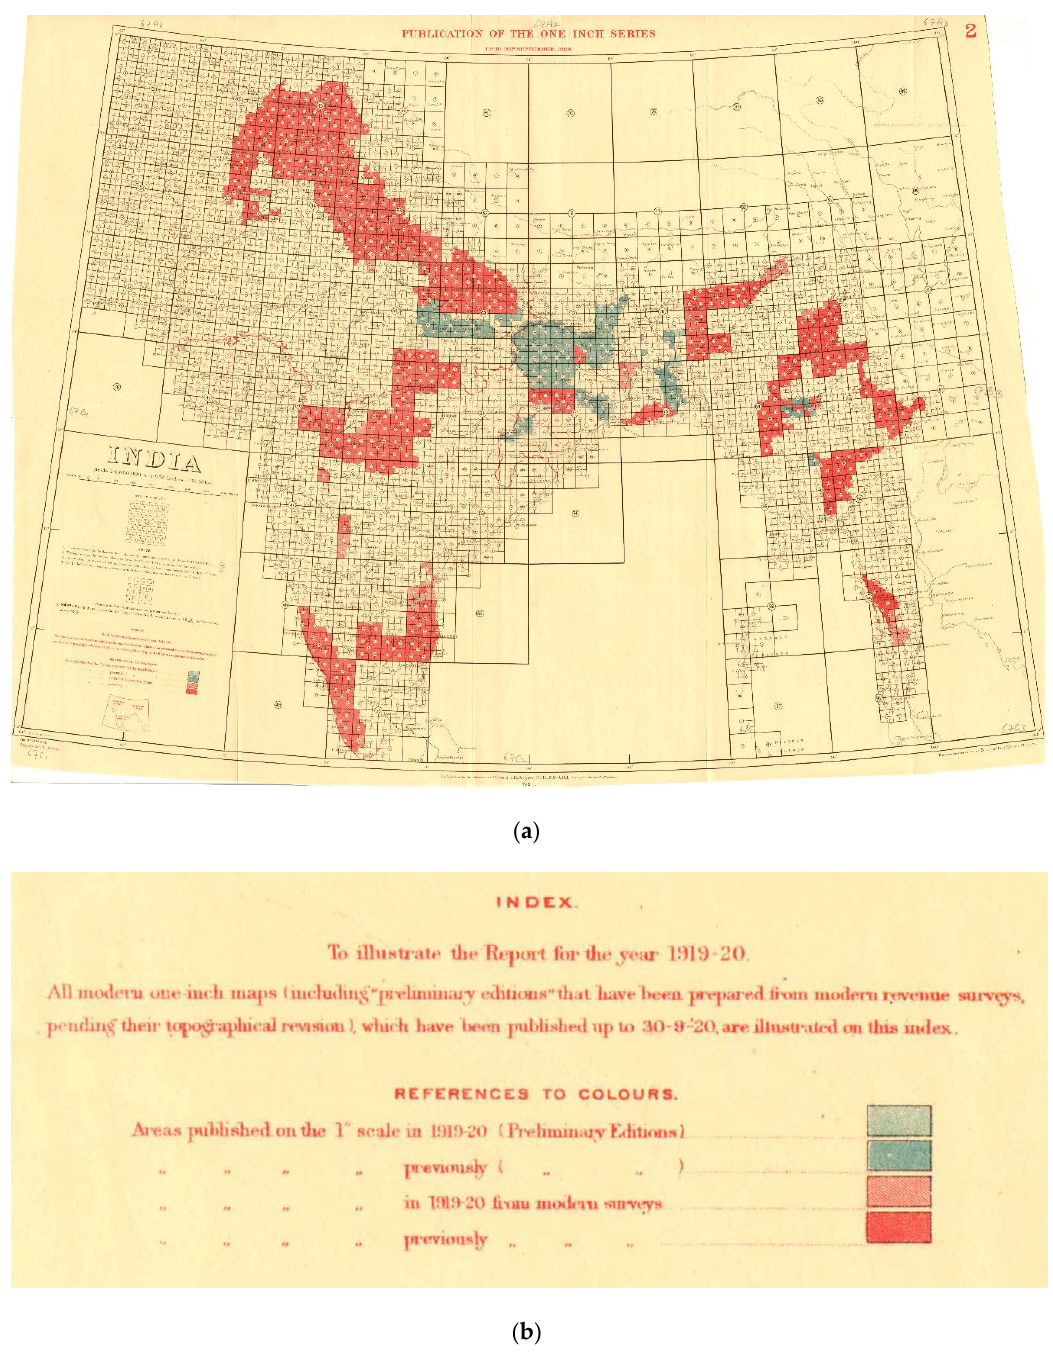
Figure 2. ( a ) Map showing structure of 1” to 1-mile map series and its publication as at 1920 (Image: Pahar.in; Public Domain [66]). ( b ) Close-up of the legend from the same map (Image: Pahar.in; Public Domain [66]).